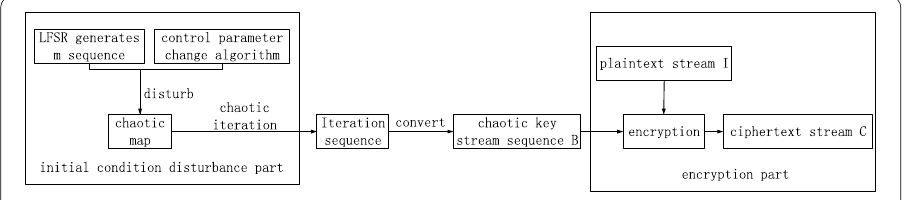
Fig. 4 Structural model of the improved